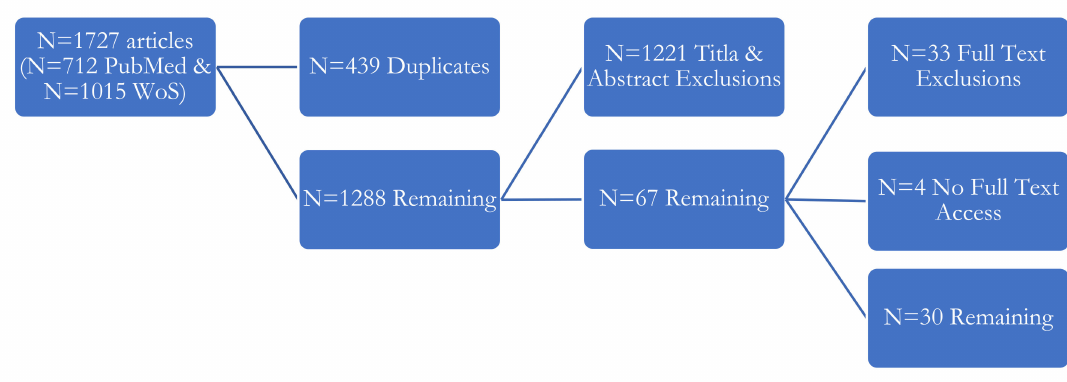
Figure 2. Modified PRISMA flow diagram